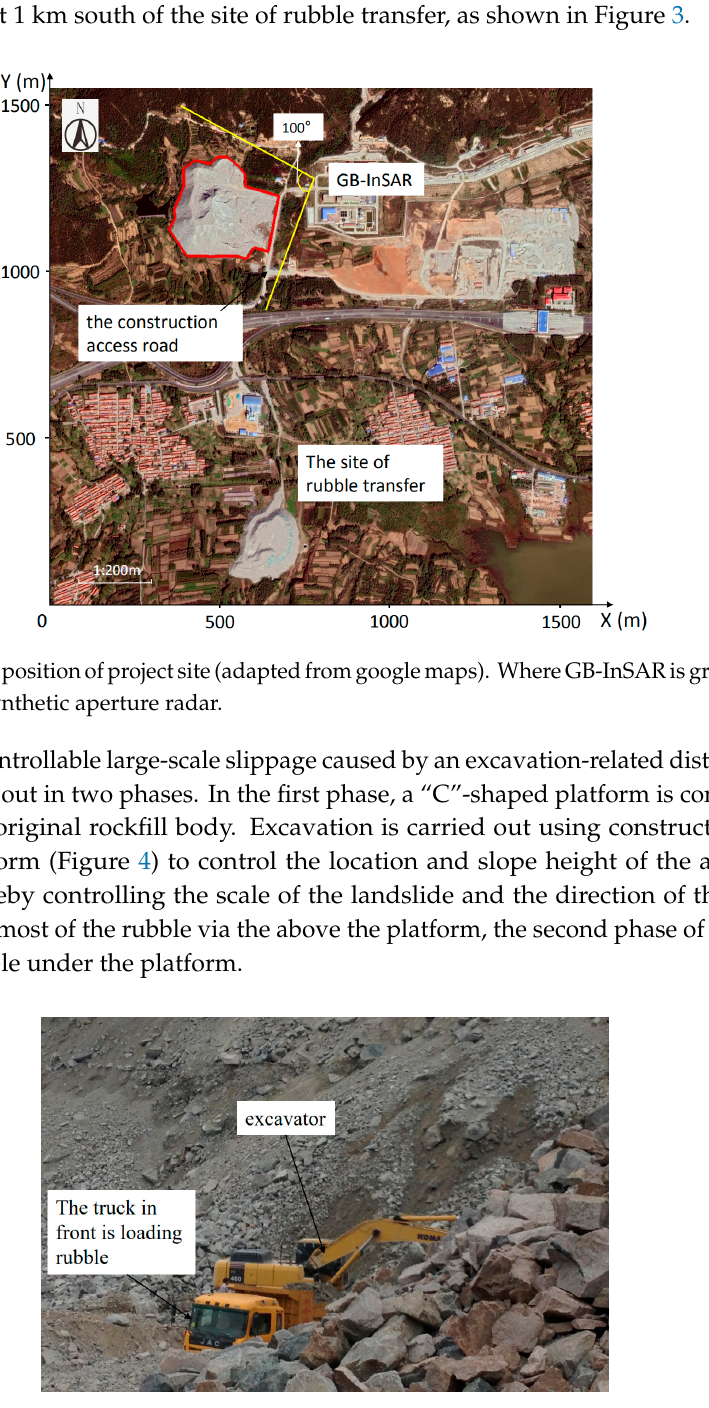
Figure 4. Loading and transportation.